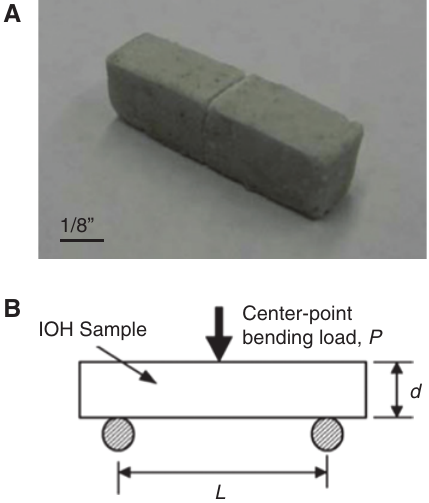
Figure 1 (A) Photo of a tested IOH sample. (B) Schematic of the flexure strength measurement experimental